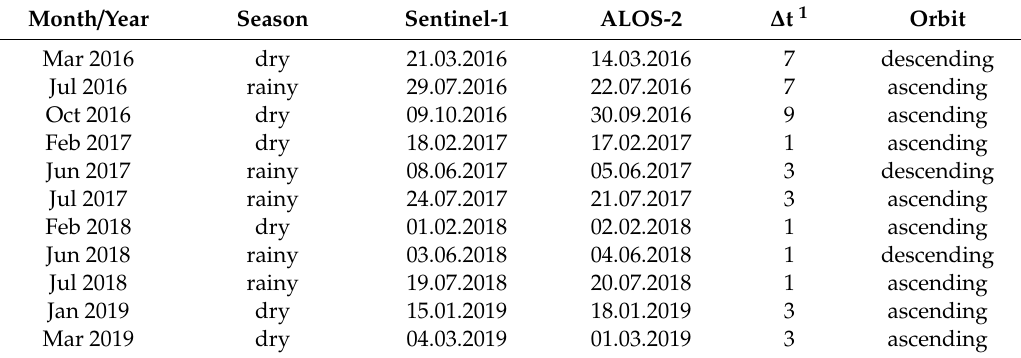
Table 1. Synthetic aperture radar (SAR) data used in this study.